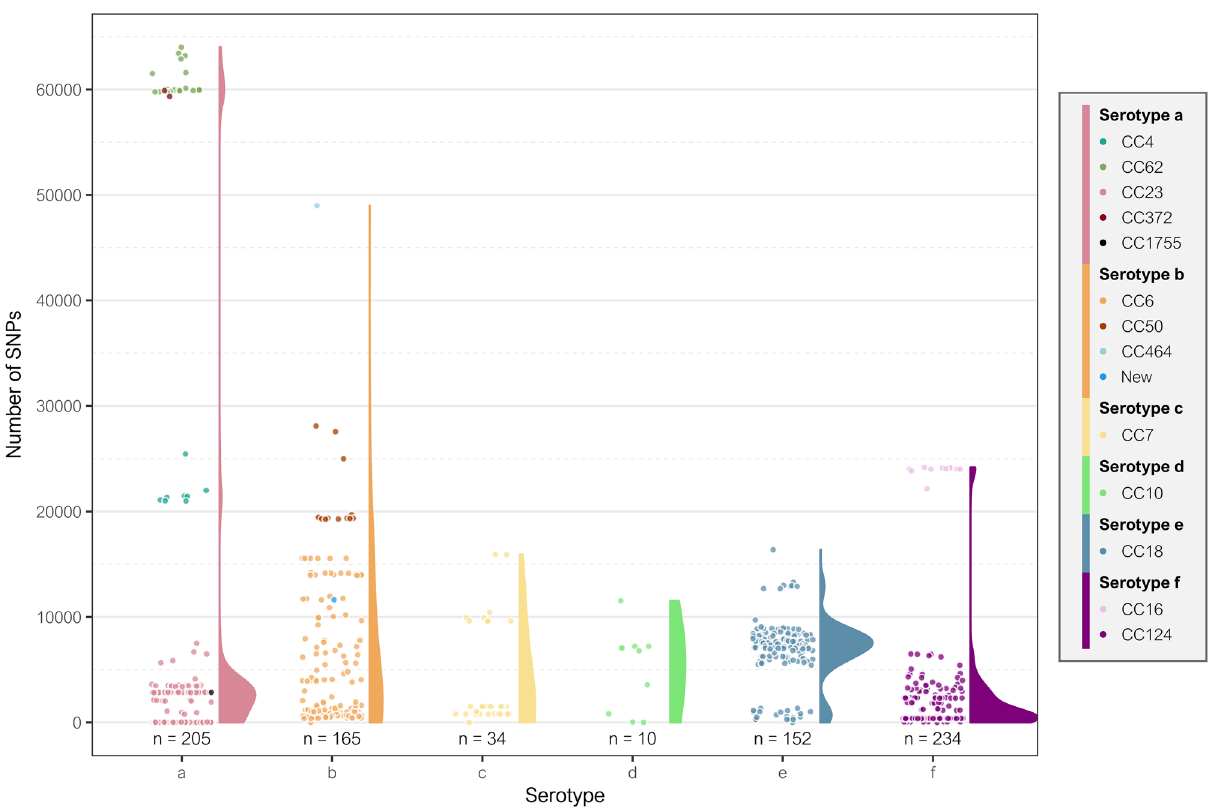
Figure 3. Core genome SNP typing of capsulated H. influenzae genomes. Each dot reflects the number of SNPs found in serotype a, b, c, d, e, and f genomes compared to the reference genomes NML-Hia-1 [CC23] (NZ_ CP017 811.1), 10810 [CC6] (NC_ 016809.1), M12125 [CC7] (SRR98 47495), PTHi-10983 [CC10] (ERR25 60729), M15895 [CC18] (NZ_ CP031 249.1), and KR494 [CC124] (NC_ 022356.1), respectively. Split violin plots show the distribution of the genomes based on the number of SNPs by each